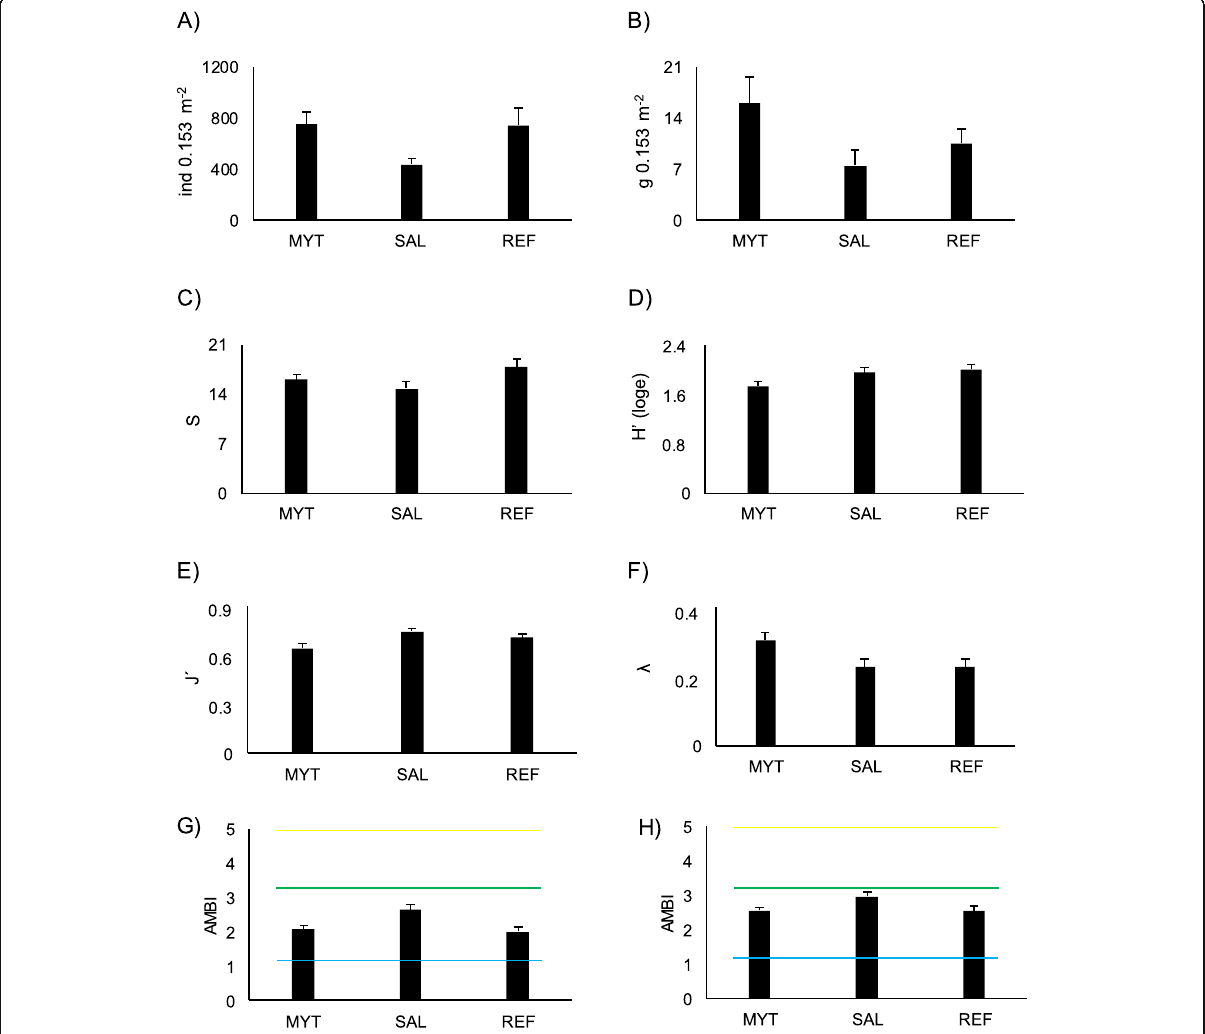
Fig. 3 Average values (standard error) for the ENV factor of total abundance ( a ), total biomass ( b ), species richness ( c ), Shannon-Wiener diversity ( d ), Pielou evenness ( e ), Simpson dominance ( f ), AMBI-1 ( g ), AMBI-2 ( h ). The solid line in g and h represents the cutoff values for levels of disturbance according to AMBI: Undisturbed (blue, 1.2), Slightly disturbed (green, 3.3) and Moderately disturbed (yellow,